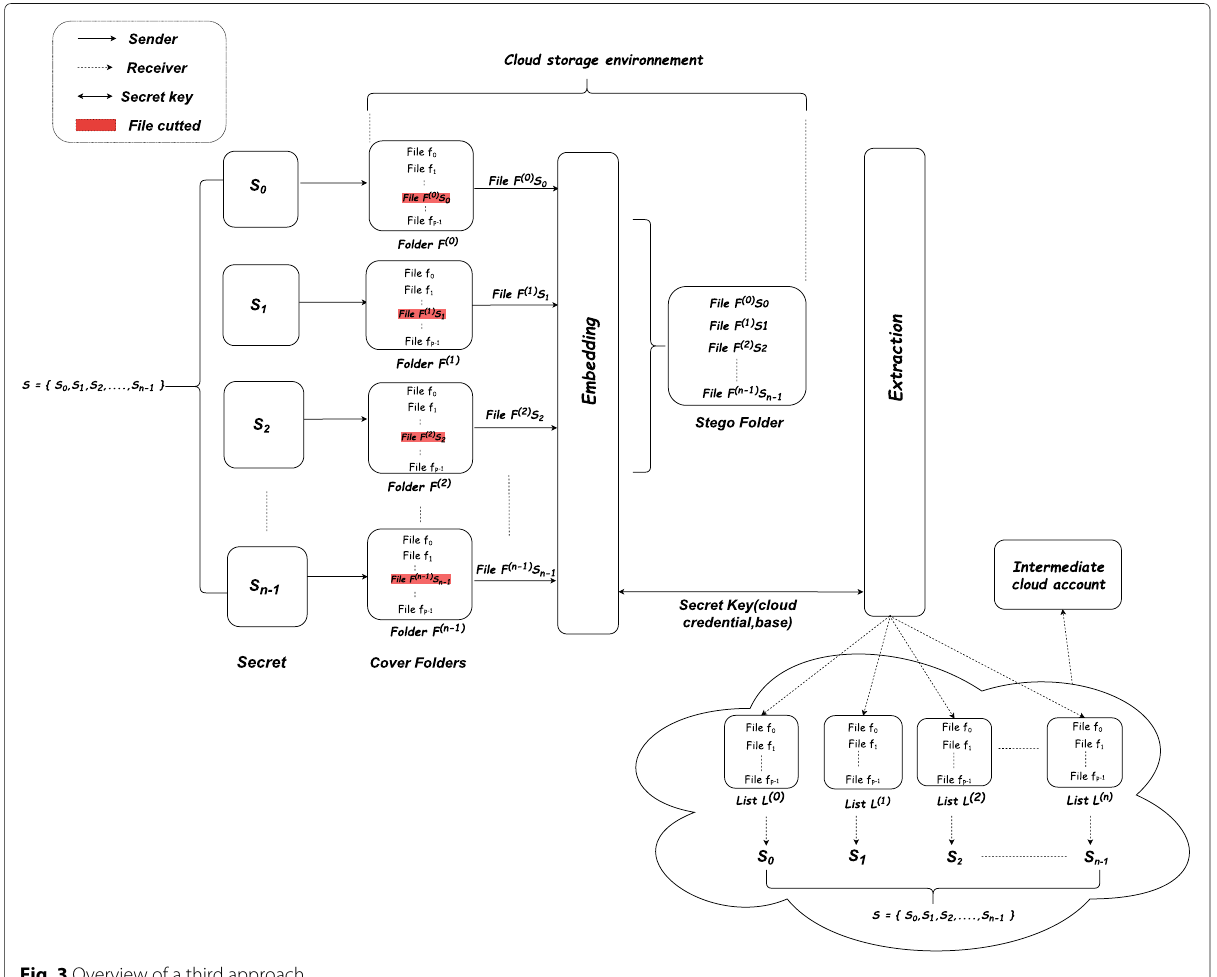
Fig. 3 Overview of a third